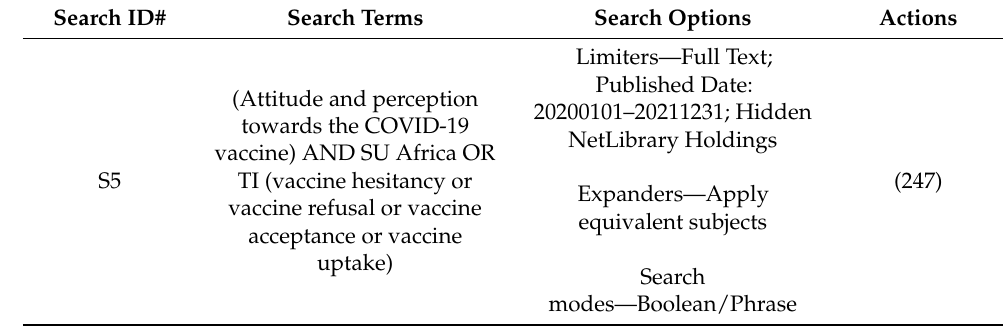
Table A1. EBSCO host search